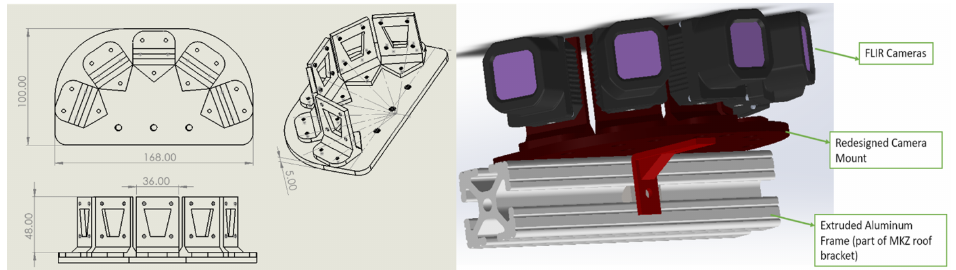
Figure 3. Mount designed for the five thermal